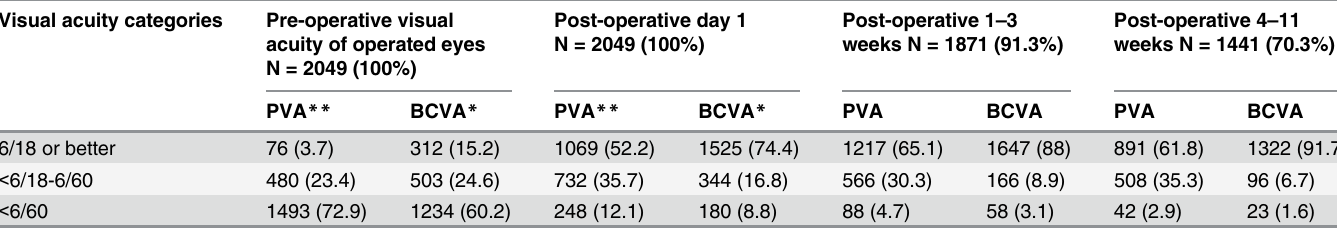
Table 3. Visual acuity at follow-up visits. Visual acuity